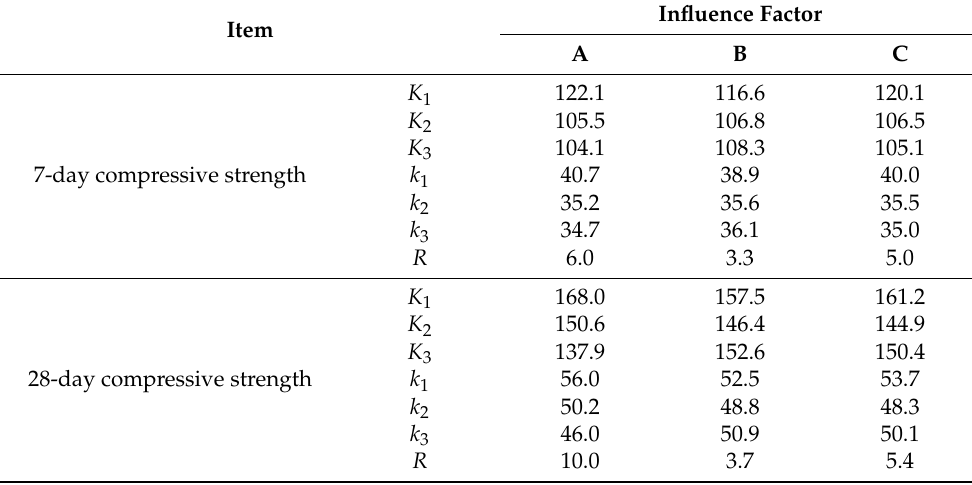
Table 5. The range analysis results of 7-day and 28-day compressive strength